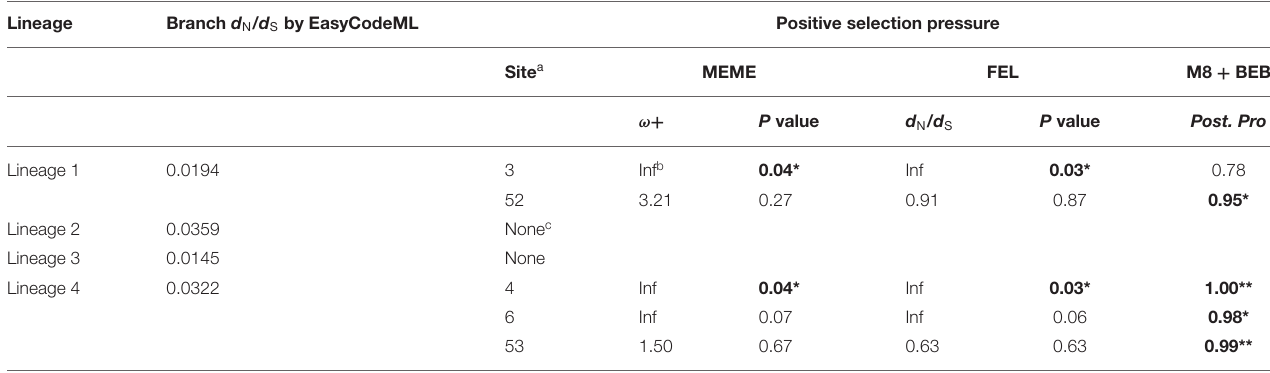
TABLE 2 | Comparison of selection pressures of APPV E2 gene for lineages 1–4.